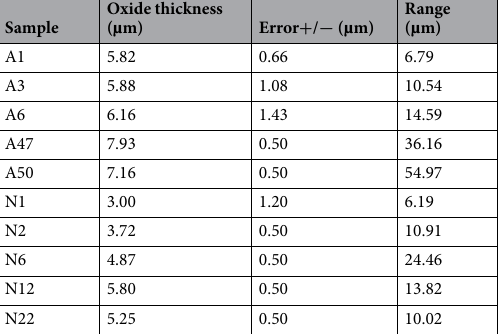
Table 2. The average UO 2 thickness observed on each uranium sample. Measurements were obtained from 80 locations on multiple cross sections of the XRT 3D renders. Errors in measurements were caused by X-ray edge artefacts, micro-porosity in the UO 2 and minor overlapping of phase densities between the grout and UO 2 . Error estimates were obtained by measuring the oxide thickness three times: at the lowest, middle and highest threshold x-ray signal perceived to represent the UO 2 for rendering the 3D image. The middle measurement was then used as the final value, with the associated maximum and minimum measurement value error range. The range column represents the range in thicknesses across the surfaces of each sample, which varied according to the geometry of the sample surface. For example, the corners of each rectangular sample generally exhibited greater oxide thicknesses than the flat face surfaces.